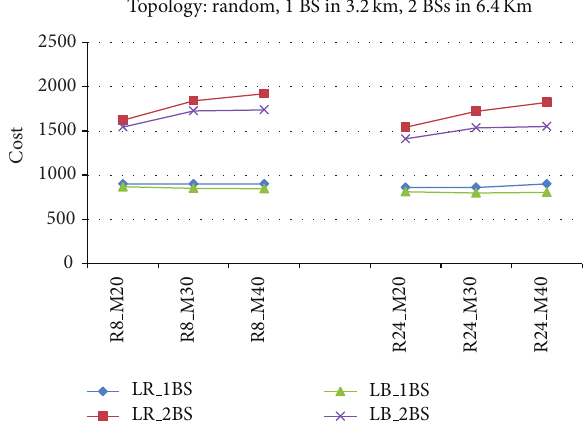
Figure 13: Deployment cost with different number of BS in random topology.